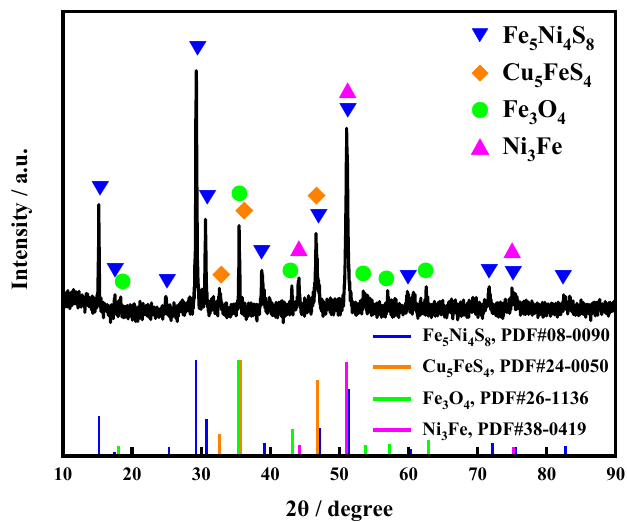
Figure 2. XRD pattern of the low-nickel matte.